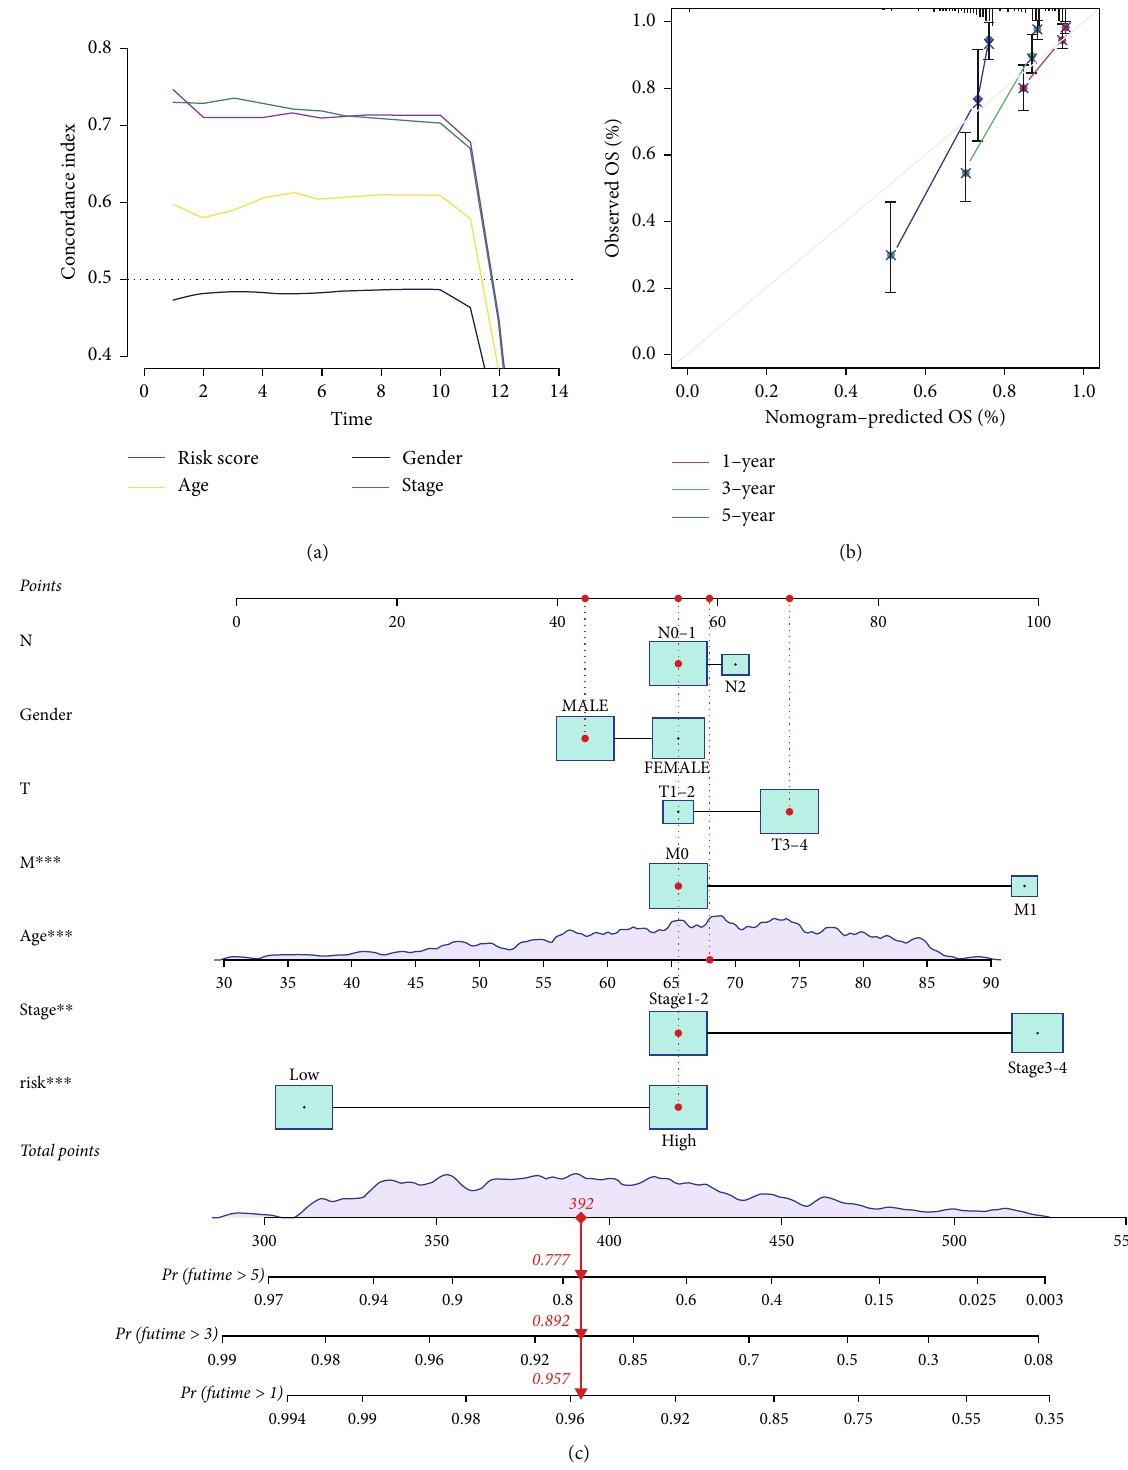
Figure 4: Evaluation of the m 5 CRlncRNAs model and development of a nomogram. (a) C -index of clinical characteristics and the model. (b) Calibration plot of a nomogram. (c) The nomogram predicts the ability of 1-, 3-, and 5-years OS rates of CRC